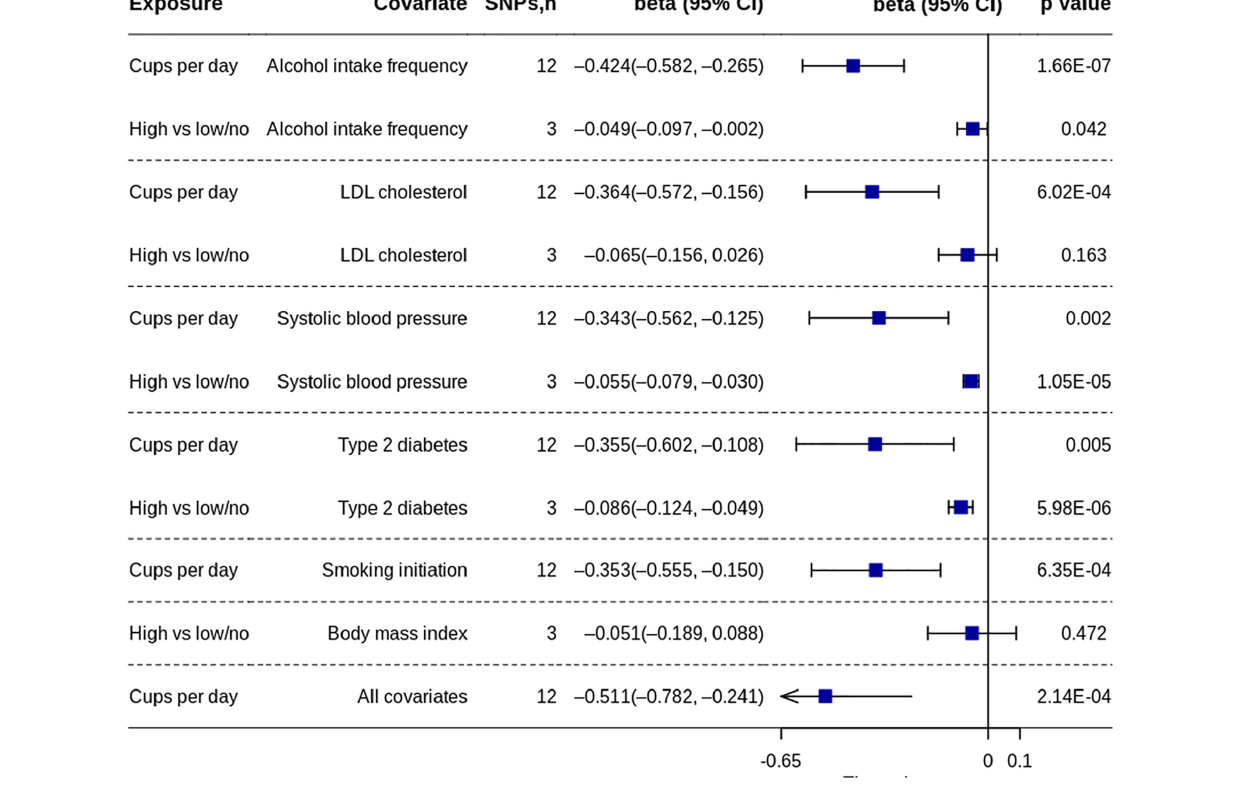
FIGURE 4 | Multivariable MR analyses of coffee consumption on gray matter volume. MR, Mendelian randomization; SNP, single nucleotide